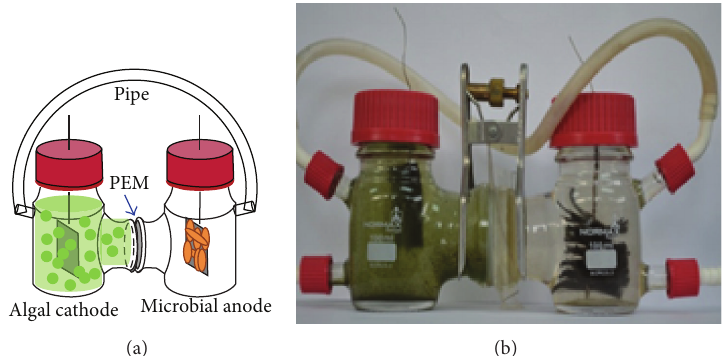
Figure 1: Schematic diagram (a) and experimental setup (b) of an MCC. CO 2 is transported through a silicon tube, fixed on the